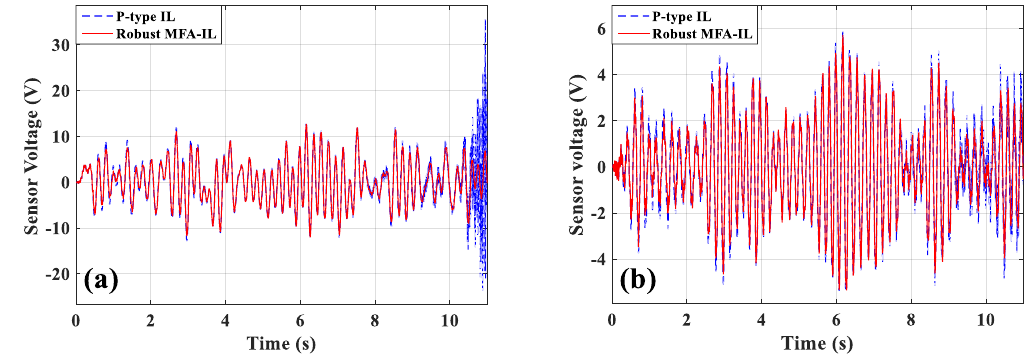
Figure 15. The time-domain responses of sensors: ( a ) Sensors a / b , ( b ) sensor c.